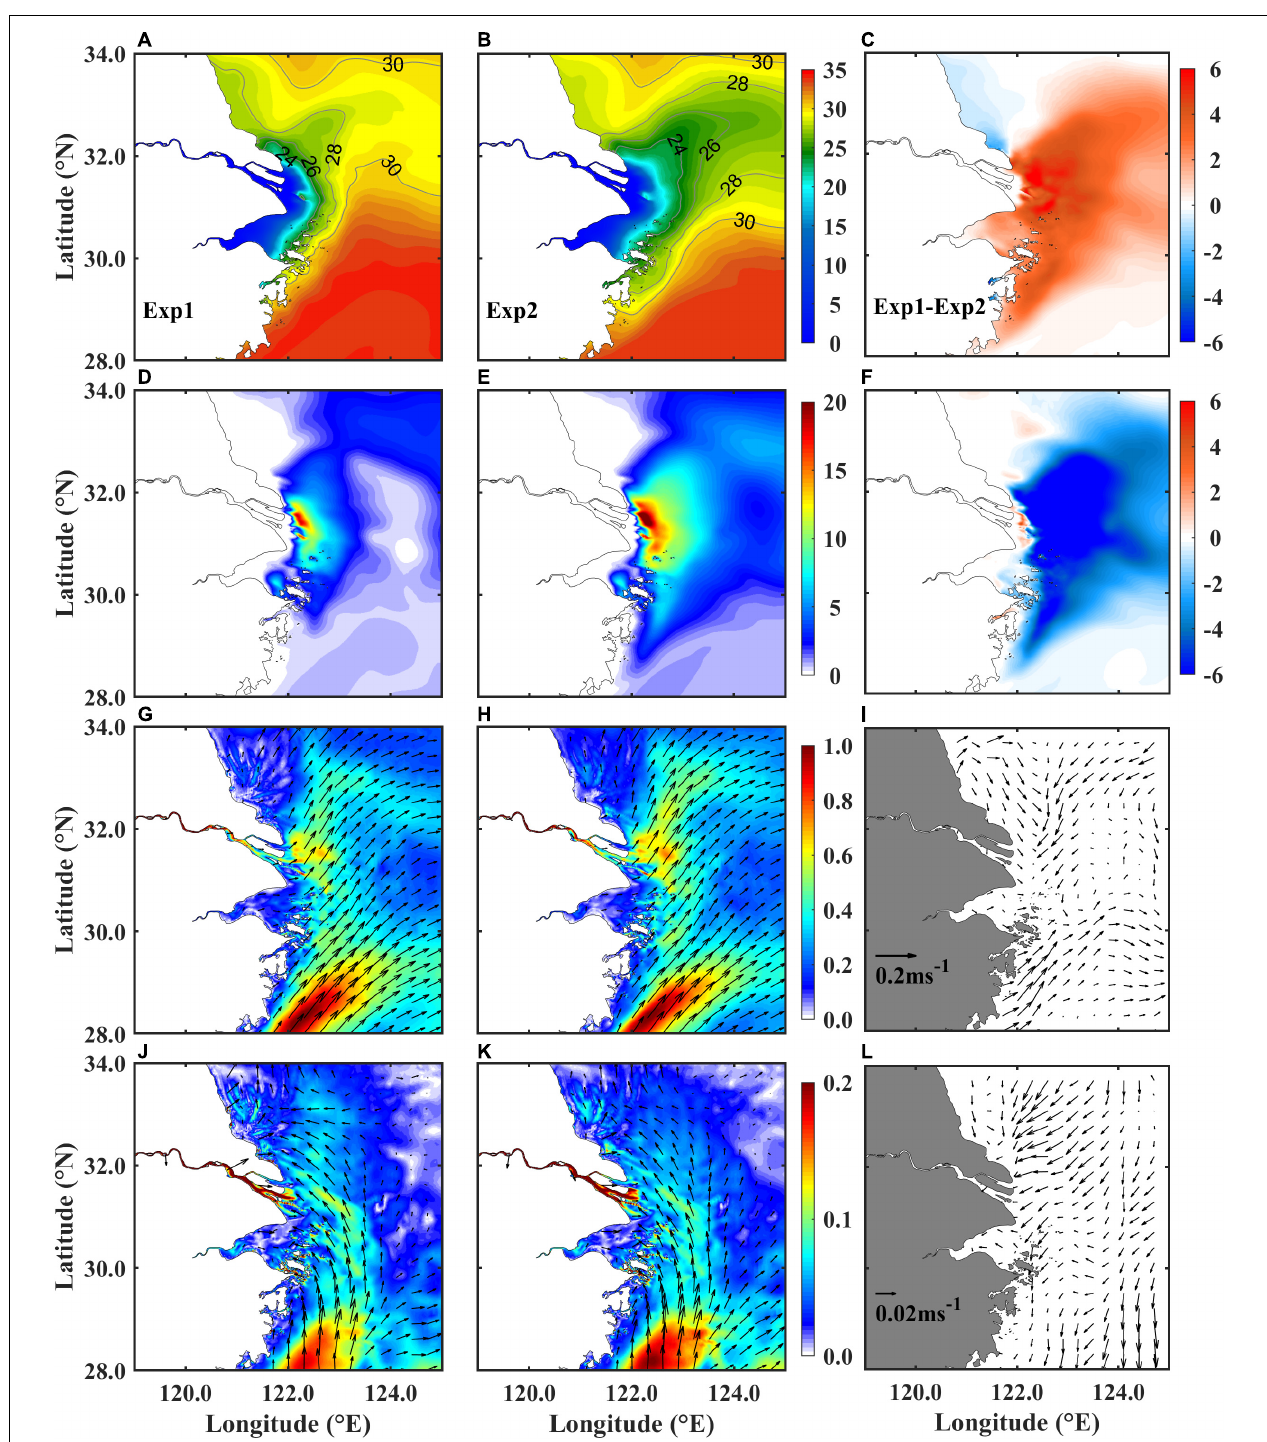
FIGURE 8 | The (A–C) surface salinity, (D–F) difference between the bottom and surface salinity (bottom minus surface), (G–I) surface current, and (J–L) bottom current (unit: ms − 1 ) averaged from July 11 to 19 in (A,D,G,J) Exp1 (CR), (B,E,H,K) Exp2 (NoWave), and (C,F,I,L) Exp1–Exp2. Color indicates magnitude and arrows for